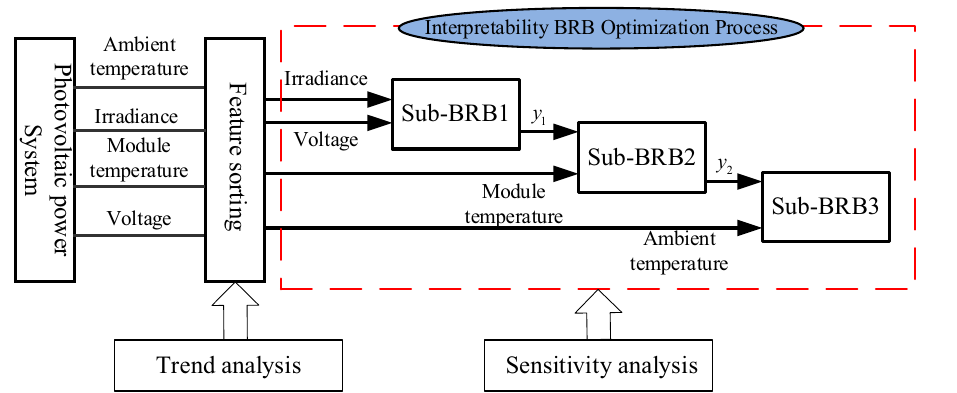
Figure 7. The relationship between each attribute and output power.